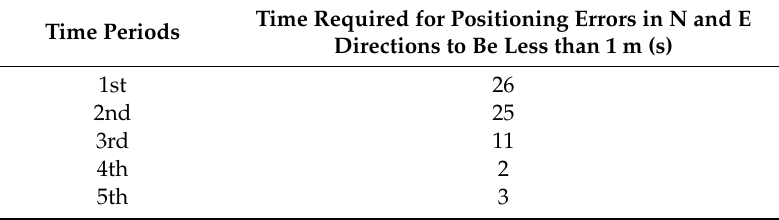
Table 5. The time required for positioning errors in N and E directions less than 1 m of all time periods. Time Required for Positioning Errors in N and E Time Periods Directions to Be Less than 1 m